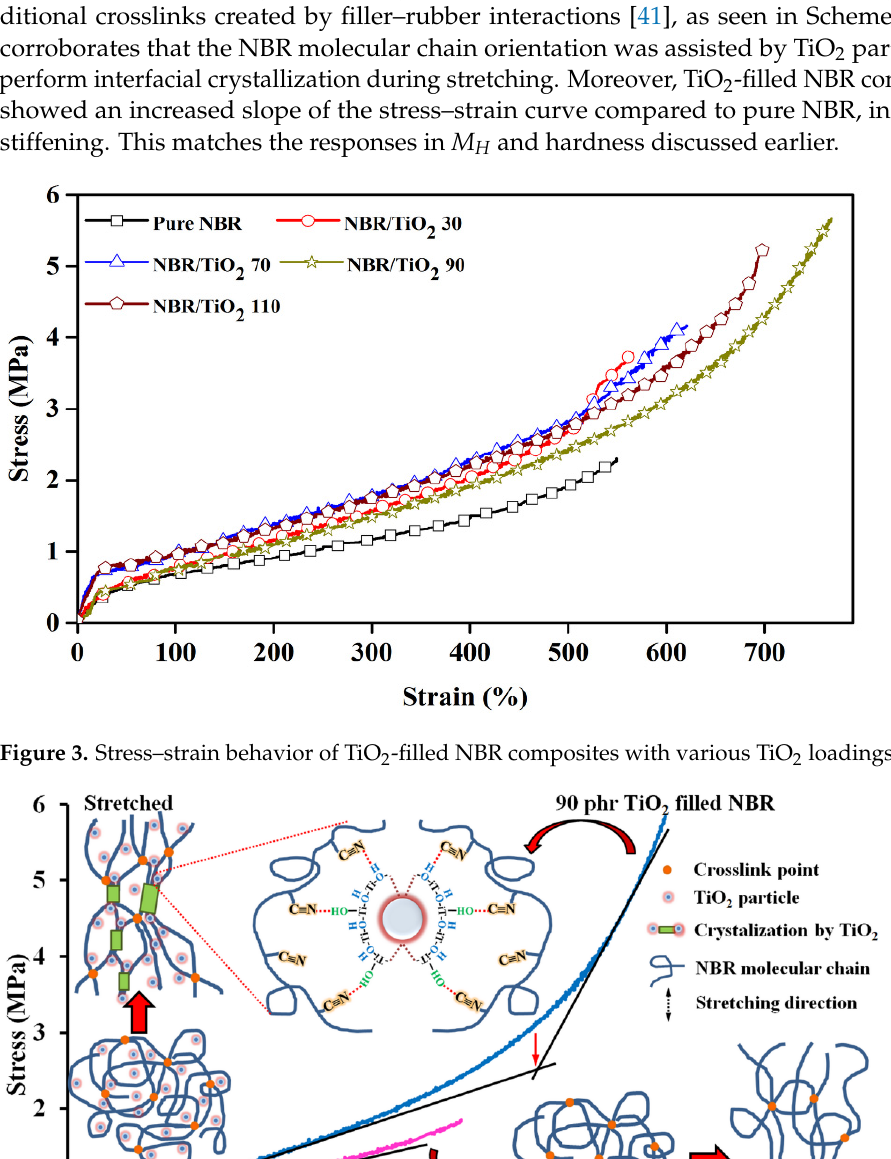
Scheme 2. Schematic illustration of the proposed reinforcing mechanism and strain-induced crys- tallization in TiO 2 -filled NBR composites.